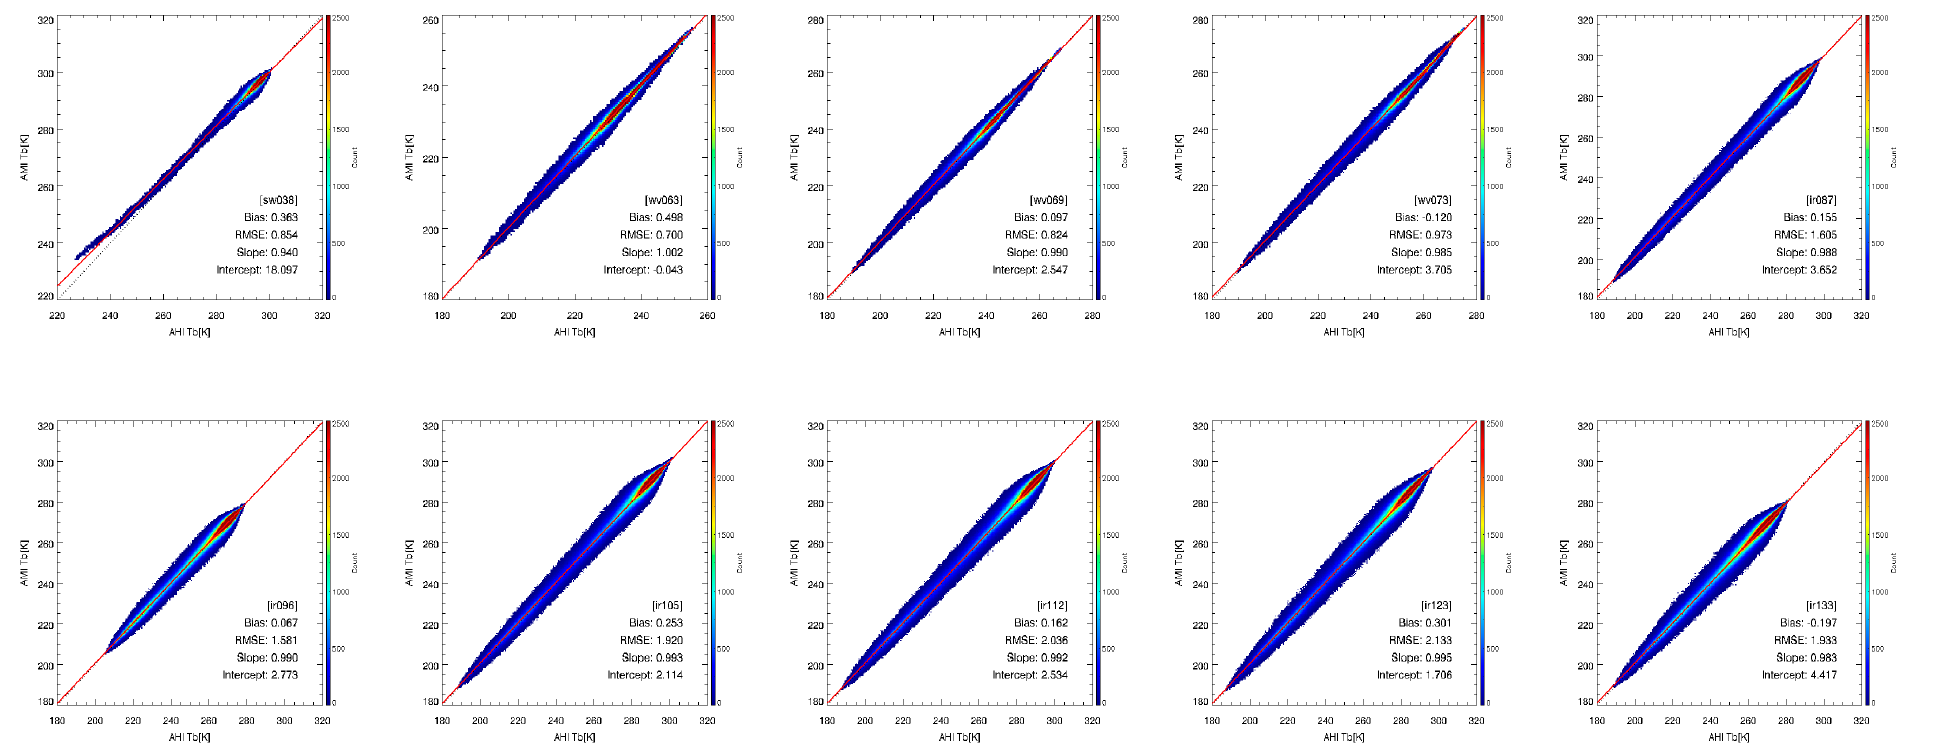
Figure 12. Scatter plots of TB from GK2A AMI and Himawari-8 AHI IR channels in January 2020.